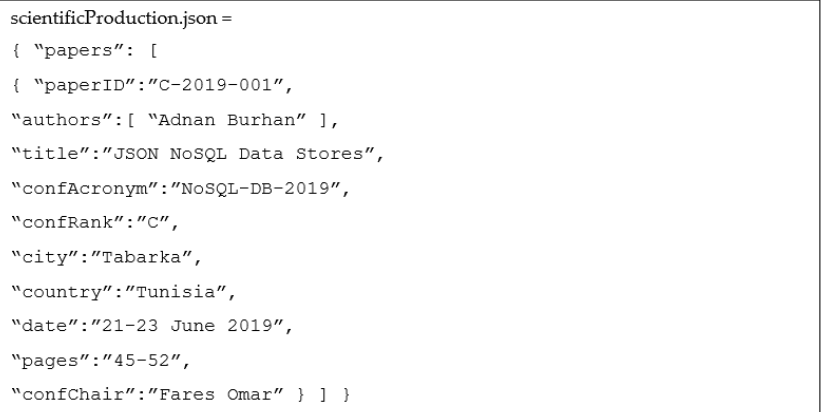
Figure 1. Initial state of the “ scientificProduction.json ” JSON instance file.